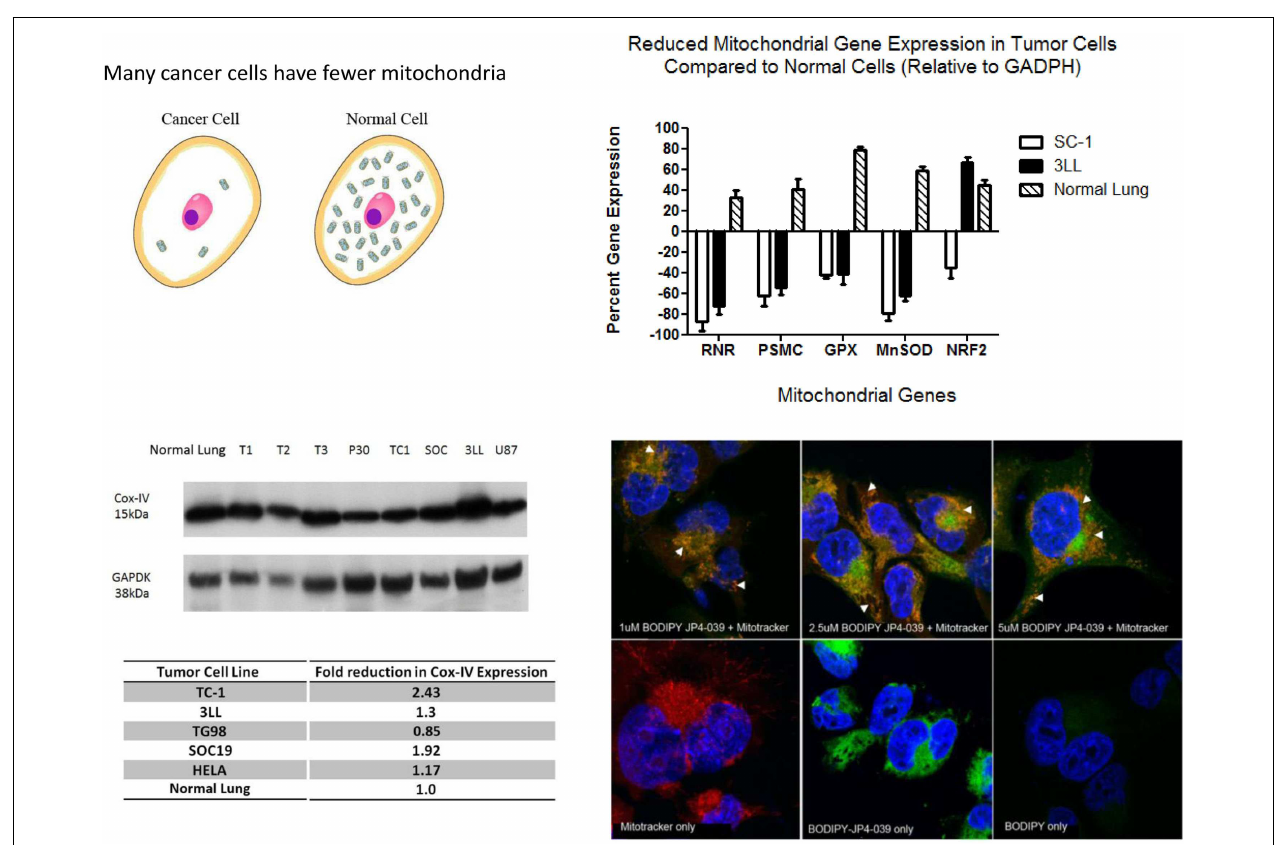
FIGURE 2 | How JP4-039 protects normal tissue